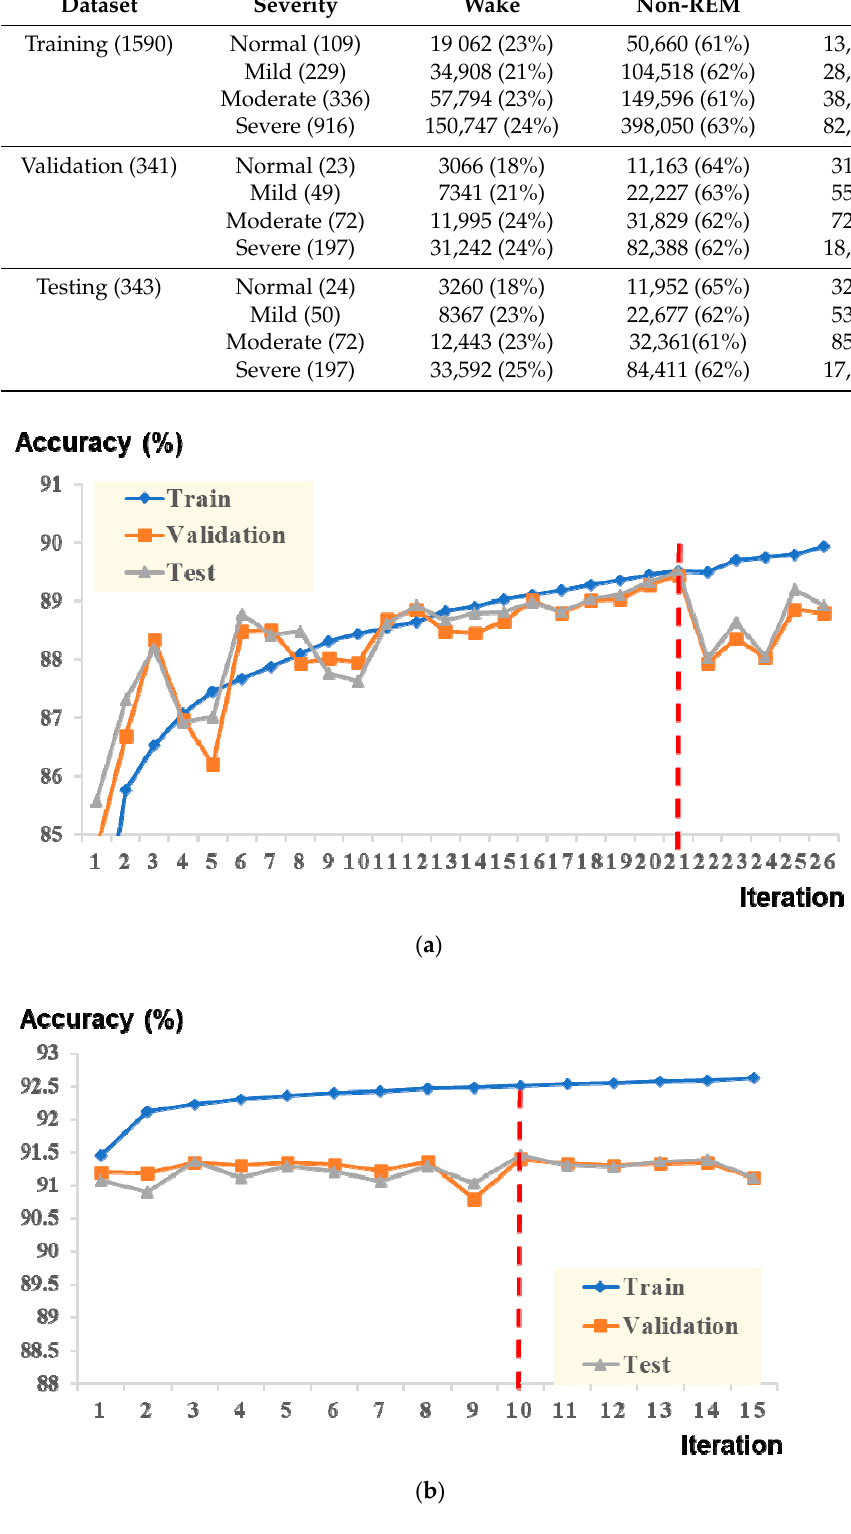
Figure 4. Evaluation of training times for best training accuracy. One iteration means that all the data samples in the entire training set have been used to train a deep learning model. ( a ) Training/validation/test accuracy trend for a single-epoch model. ( b ) Training/validation/test accuracy trend for a multi-epoch